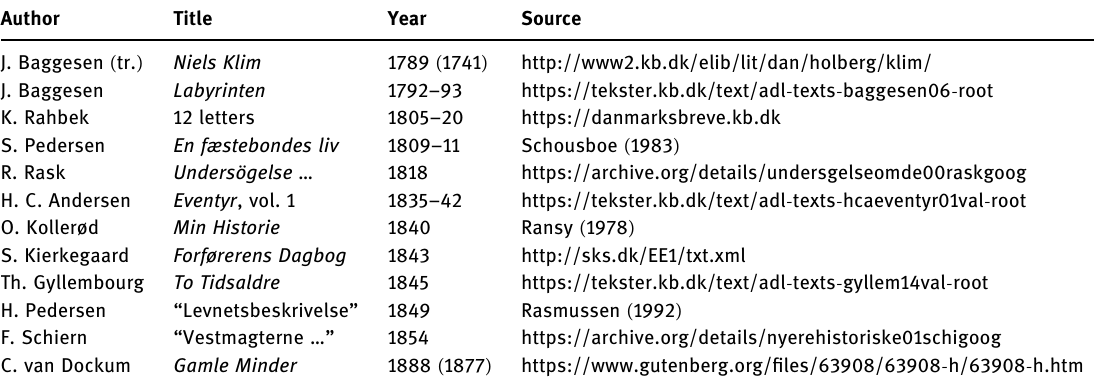
Table A1: List of primary sources; hyperlinks last checked 10 June